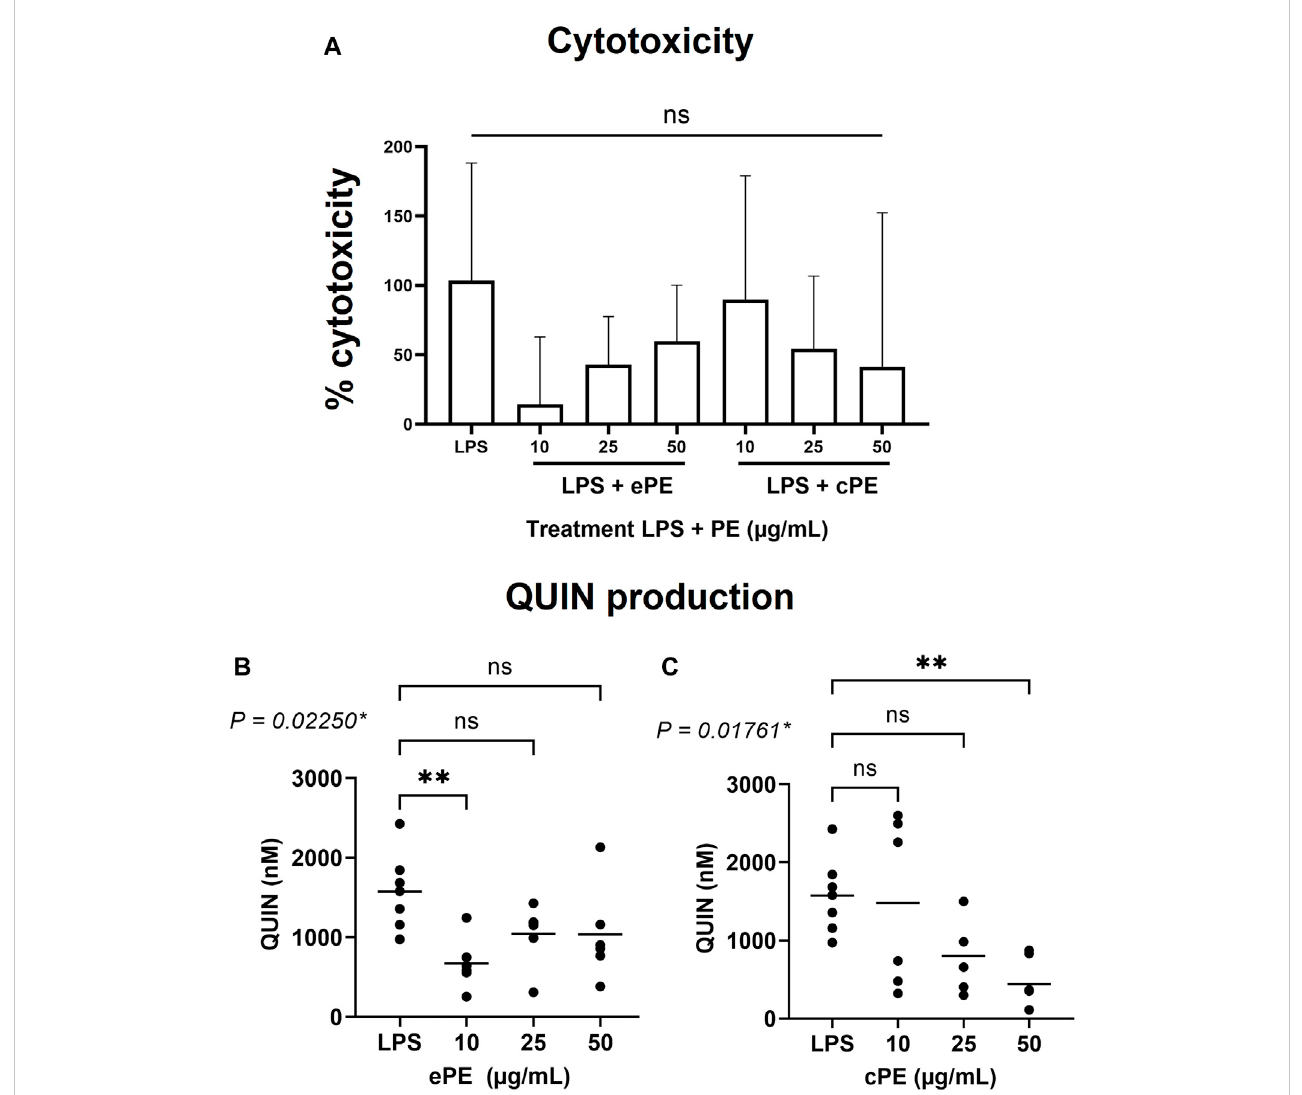
FIGURE 3 Inhibitoryeffectof C.forsteri extractsonQUINproduction.Anti-in fl ammatorypotential of C.forsteri cyclohexane(cPE)andethanolic(ePE)plantextract at10,25 or50 μ g/mlwere evaluated on QUIN producedbyMDMs inducedwith LPS(20 ng/ml)for 48H.Cytotoxicityof cPEand ePE wasevaluated onMDMs (A) as described in Materials and Methods. QUIN was quanti fi ed by GC/MS after treatment with ePE (B) and cPE (C) at various concentrations. Kruskal-Wallis test followed by a Dunn ’ s multiple comparison test were used for comparison between treatments compared to LPS condition. *, p < 0.05; **, p < 0.01; ns, non-signi fi